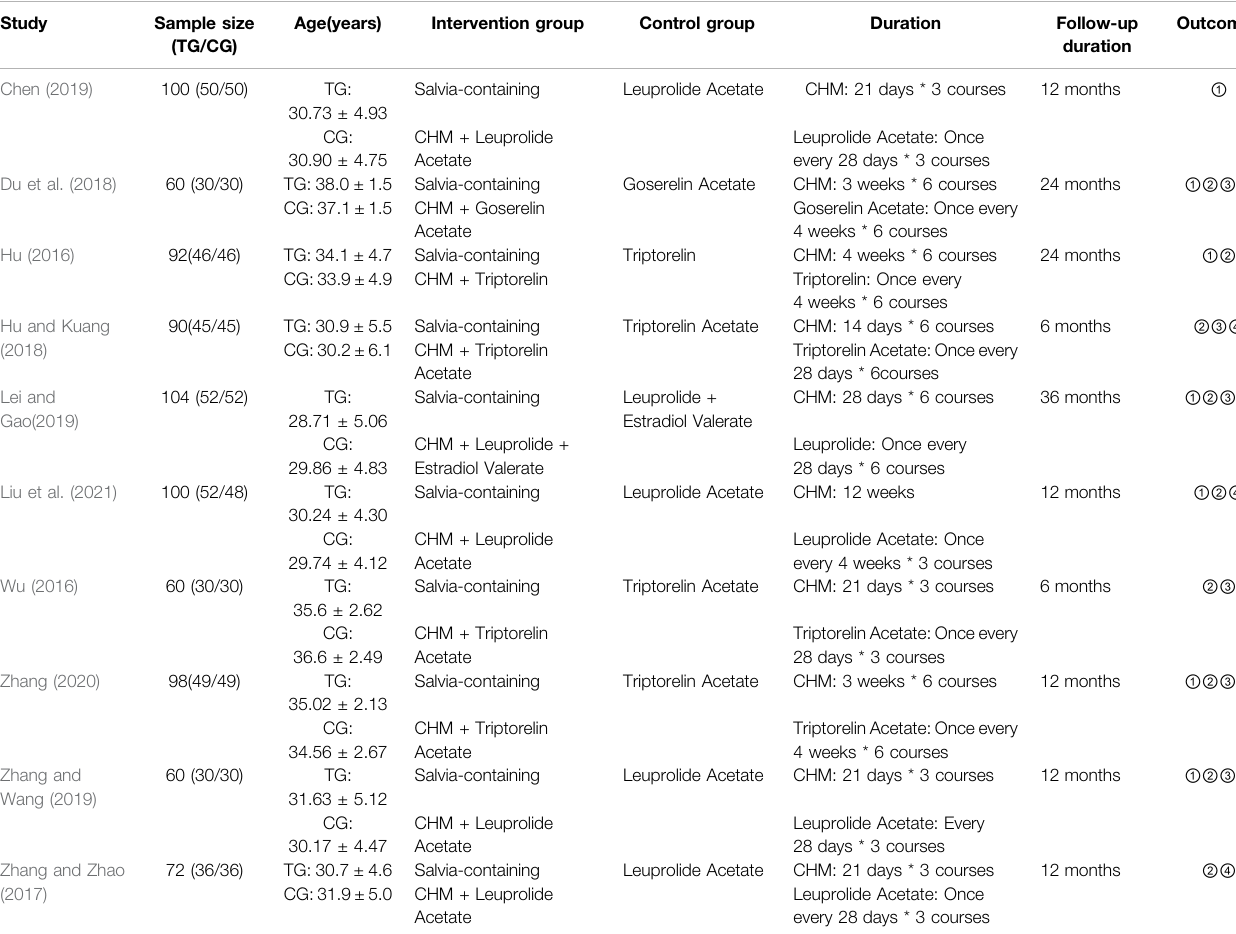
TABLE 1 | Characteristics of included